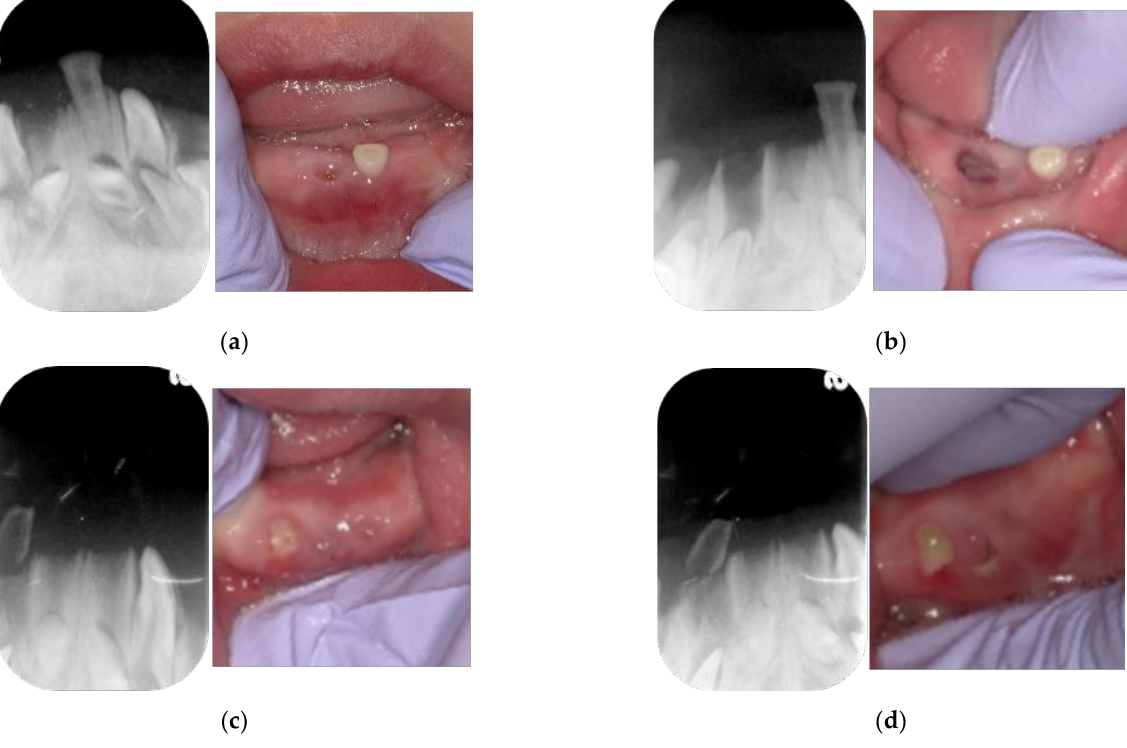
Figure 3. Periapical radiographs and intraoral photographs acquired at the ages of ( a ) 4 years and 1 month, ( b ) 4 years and 2 months, ( c ) 4 years and 8 months, and ( d ) 4 years and 11